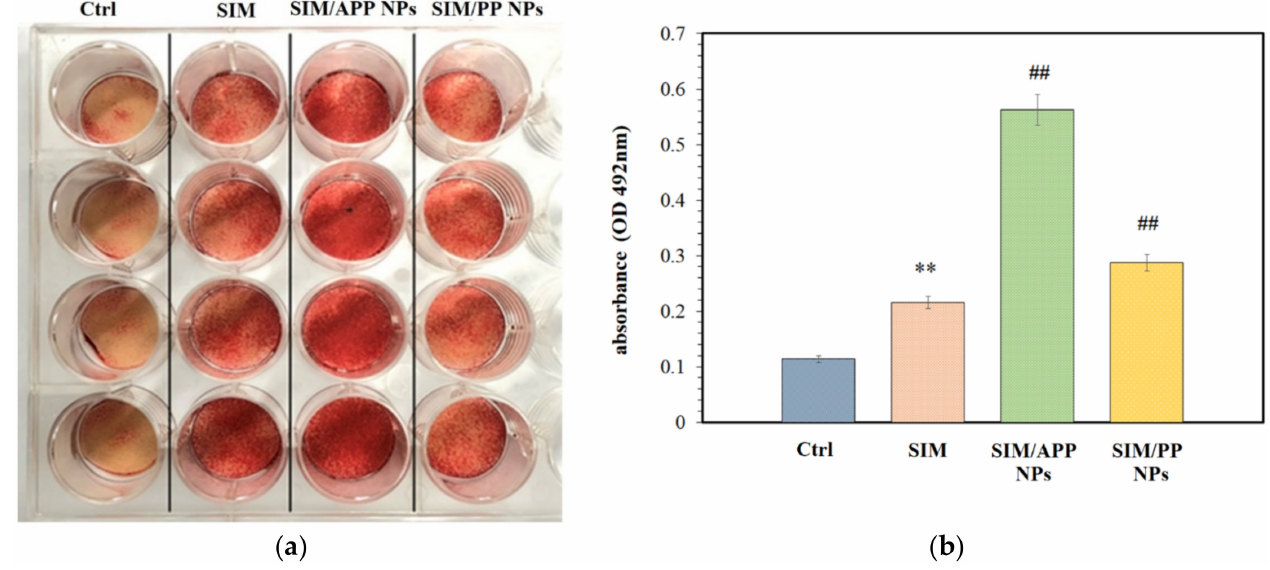
Figure 5. Effects of SIM/APP NPs, SIM/PP NPs, and positive control consisting of free simvastatin on mineralization in D1 cells. Optical photographs of various groups of wells stained with alizarin red S ( a ) and their ELISA quantitative analysis results ( b ). Values are the mean ± SD, n = 3. (**) indicates significant differences of p < 0.005 compared with the control group (Ctrl), (##) indicates significant differences of p < 0.005 compared with the SIM